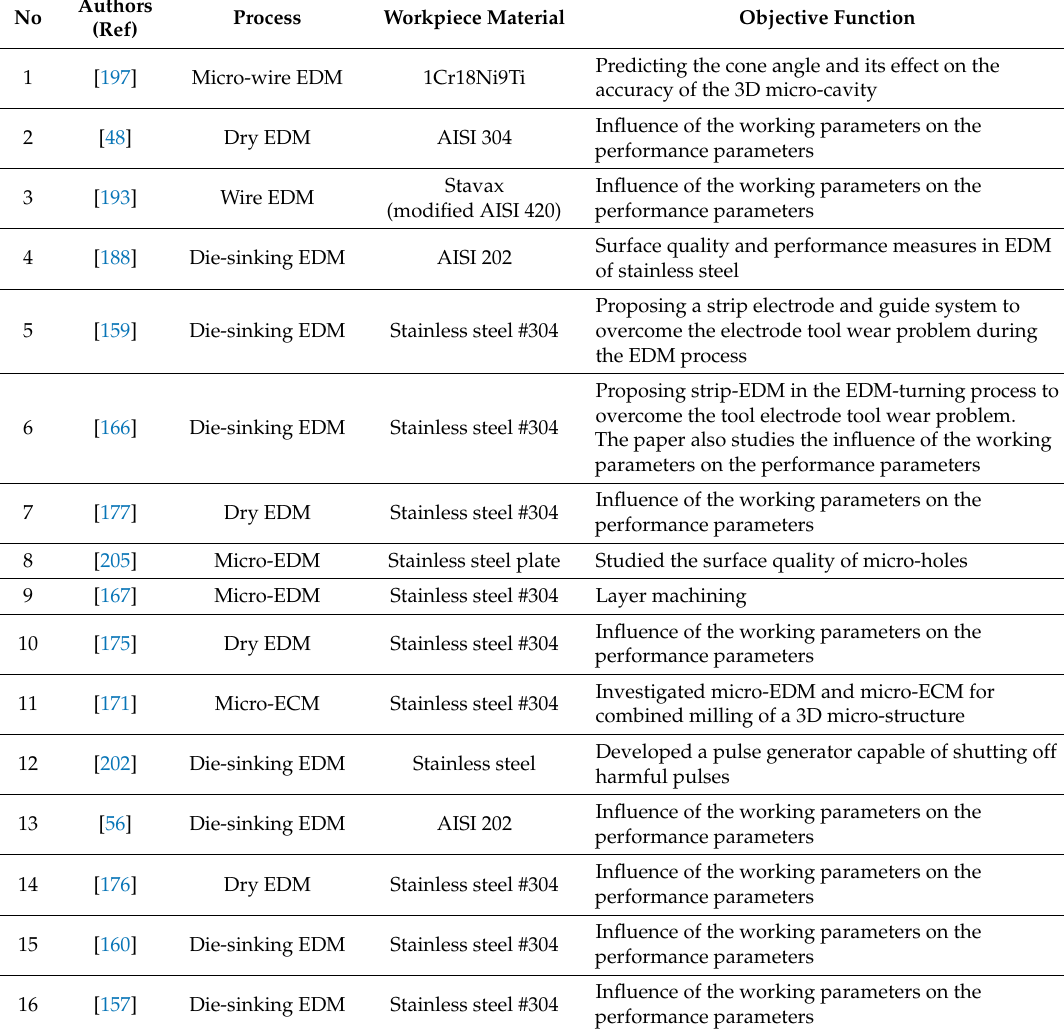
Figure 32. Relative usage of the different EDM processes utilized for studying stainless steel machining. Table 4. Summary of the studies on the EDM processing of stainless steel.